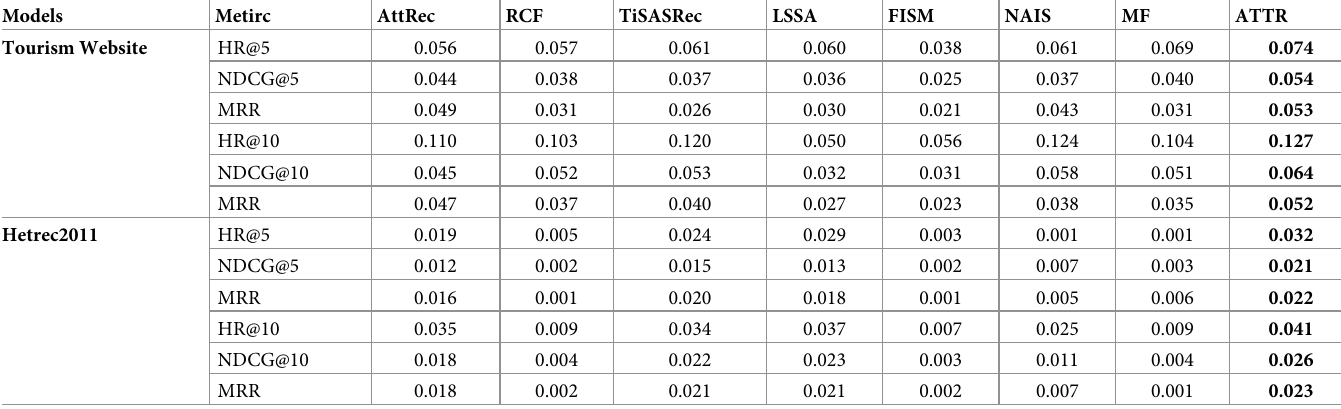
Table 3. Comparison of hit rate (HR), NDCG and MRR performance of all models on two datasets. Models